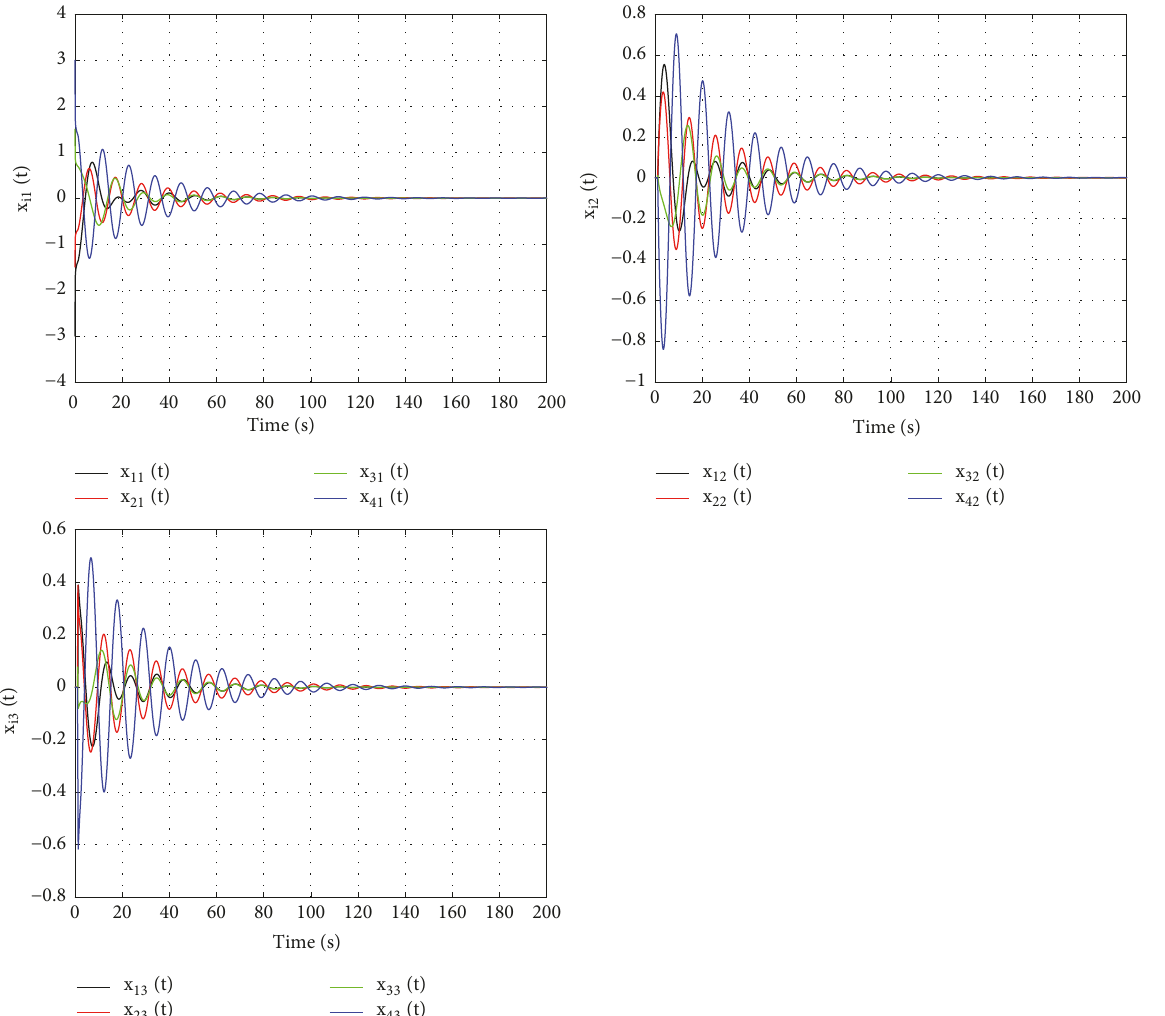
Figure 4: The trajectories of all agents’ states in the FOMAS with triple integral and symmetric time-delays when all 𝜏 𝑚 < 𝜏 in Example 2.